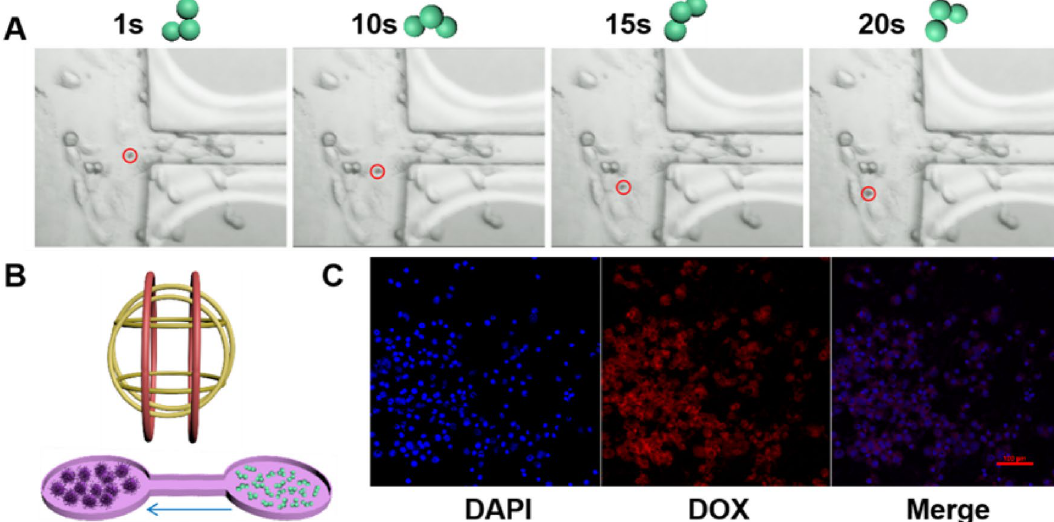
Figure 6. Experiments with targeted cancer cell treatment using magnetically actuated tri-bead/azo/DOX microrobots. ( A ) Movement position and swimming posture of a tri-bead microrobot at different times in the chamber with cancer cells. The Red circle indicates microrobot position. The rotation frequency of the actuation field is chosen as 5 Hz in the experiments. ( B ) Illustration of the magnetic control system and the experimental setup. The tri-bead/azo/DOX microrobots were placed in the right chamber and the H1299 cells were placed in the left chamber. ( C ) Cellular uptake tested performed using a confocal laser scanning microscope (CLSM), blue: DAPI; red: